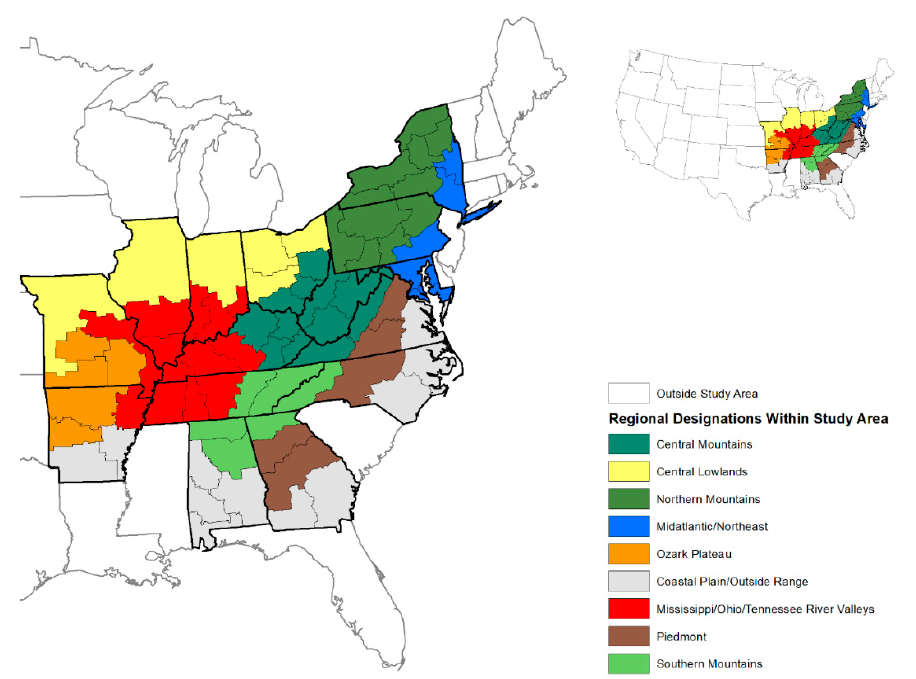
Figure 1. 15-state study area divided into nine subregions (Forest Inventory and Analysis (FIA) Research Unit Regional Categories) based on biophysical and geographic conditions. Each subregion is composed of multiple United States Forest Service (USFS) FIA Units, a group of counties containing roughly the same amount and type of forest.